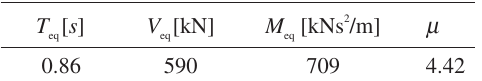
Table V. Dynamic properties of the equivalent SDOF for the Catania